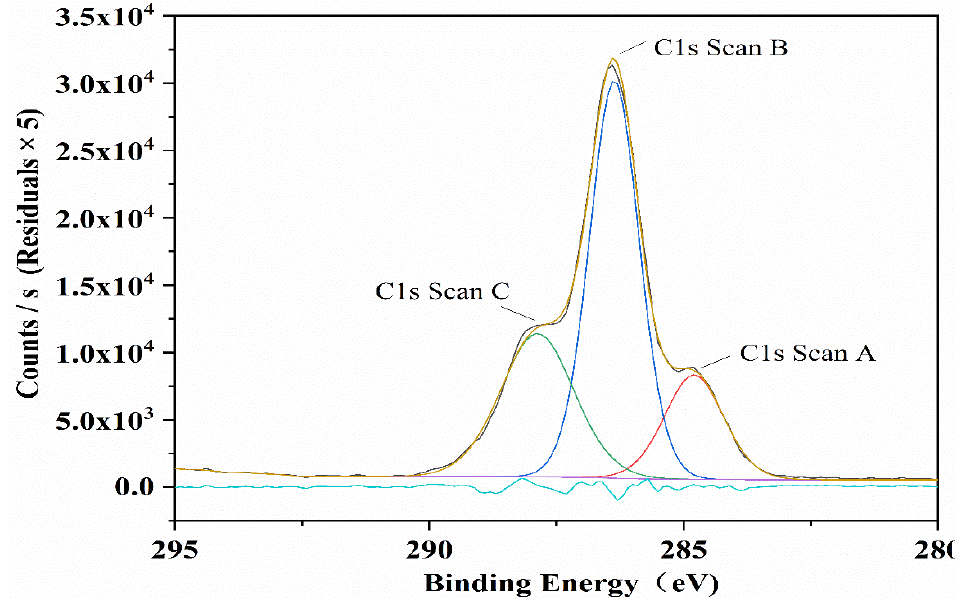
Figure 11. XPS C1s energy spectrum of CMC.